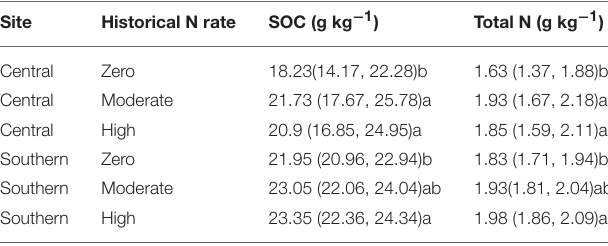
TABLE 3 | Mean soil organic C and total N (g kg − 1 ) (95% confidence interval) for historical N rates at central and southern Iowa sites.